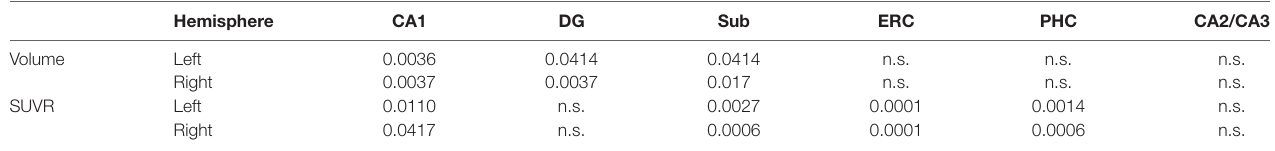
TABLE 3 | Associations between assessment scores and tau SUVR of the hippocampal subfields for A- group ( p < 0.05, FDR correction). Hemisphere Left